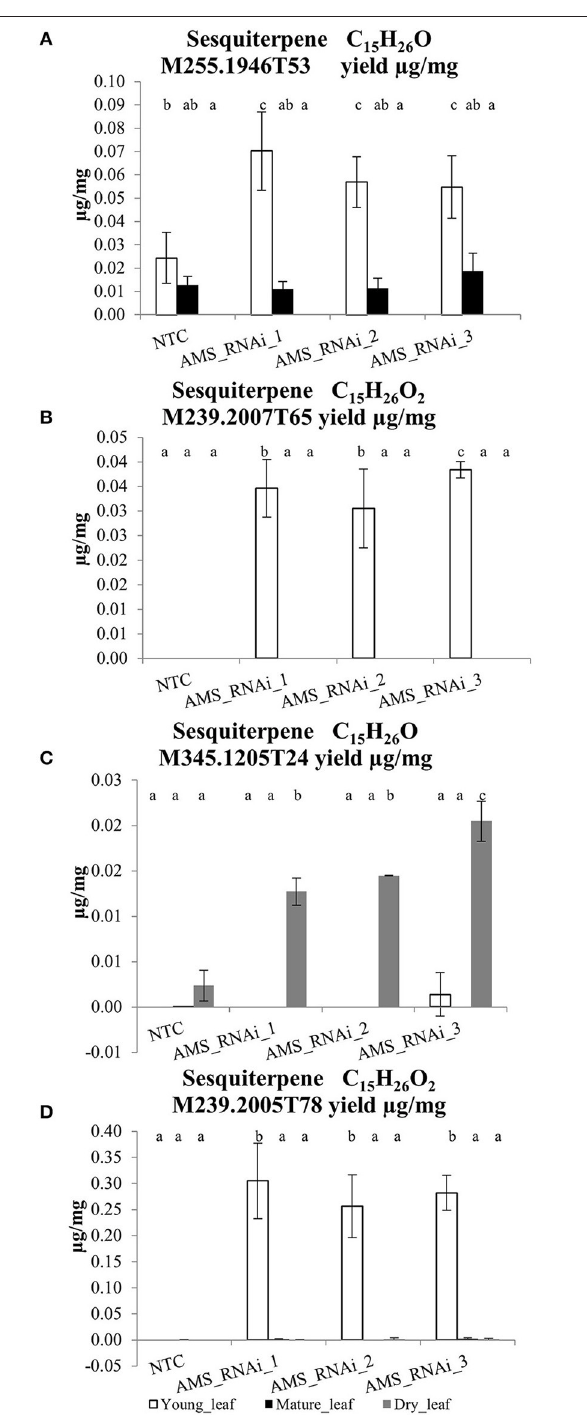
FIGURE 9 | The concentration ( µ g/mg extracted dry weight) of putative novel sesquiterpene compounds in young and mature leaves and dried pooled leaf material for the AMS silenced lines and NTCs. (A) sesquiterpene M255.1946T53, (B) sesquiterpene M345.1205T24, (C) —M239.2007T65, and (D) —sesquiterpene M239.2005T78 Error bars ± SD (NTC— n = 6, AMS _RNAi lines— n = 3). Letters represent Bonferroni test results after ANOVA, groups not sharing letters indicate statistically significant differences ( p ≤